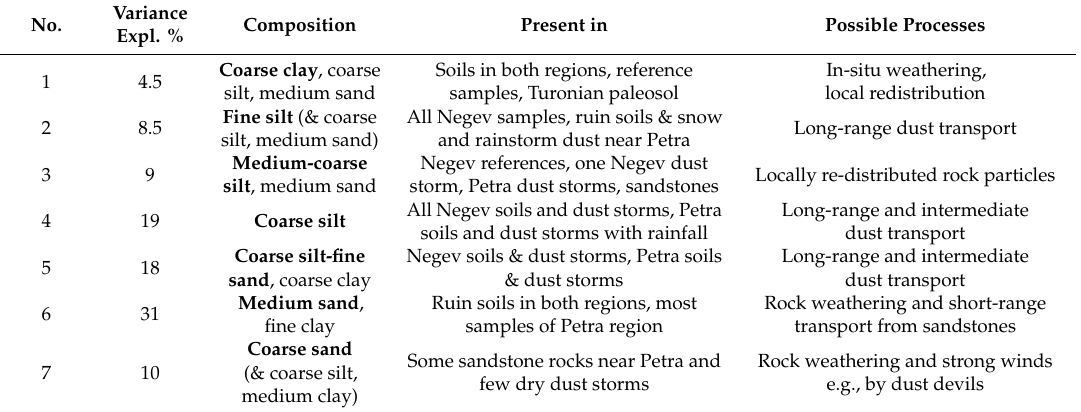
Table 7. Summary of end members that were statistically modeled with EMMAgeo. The main modes are displayed in